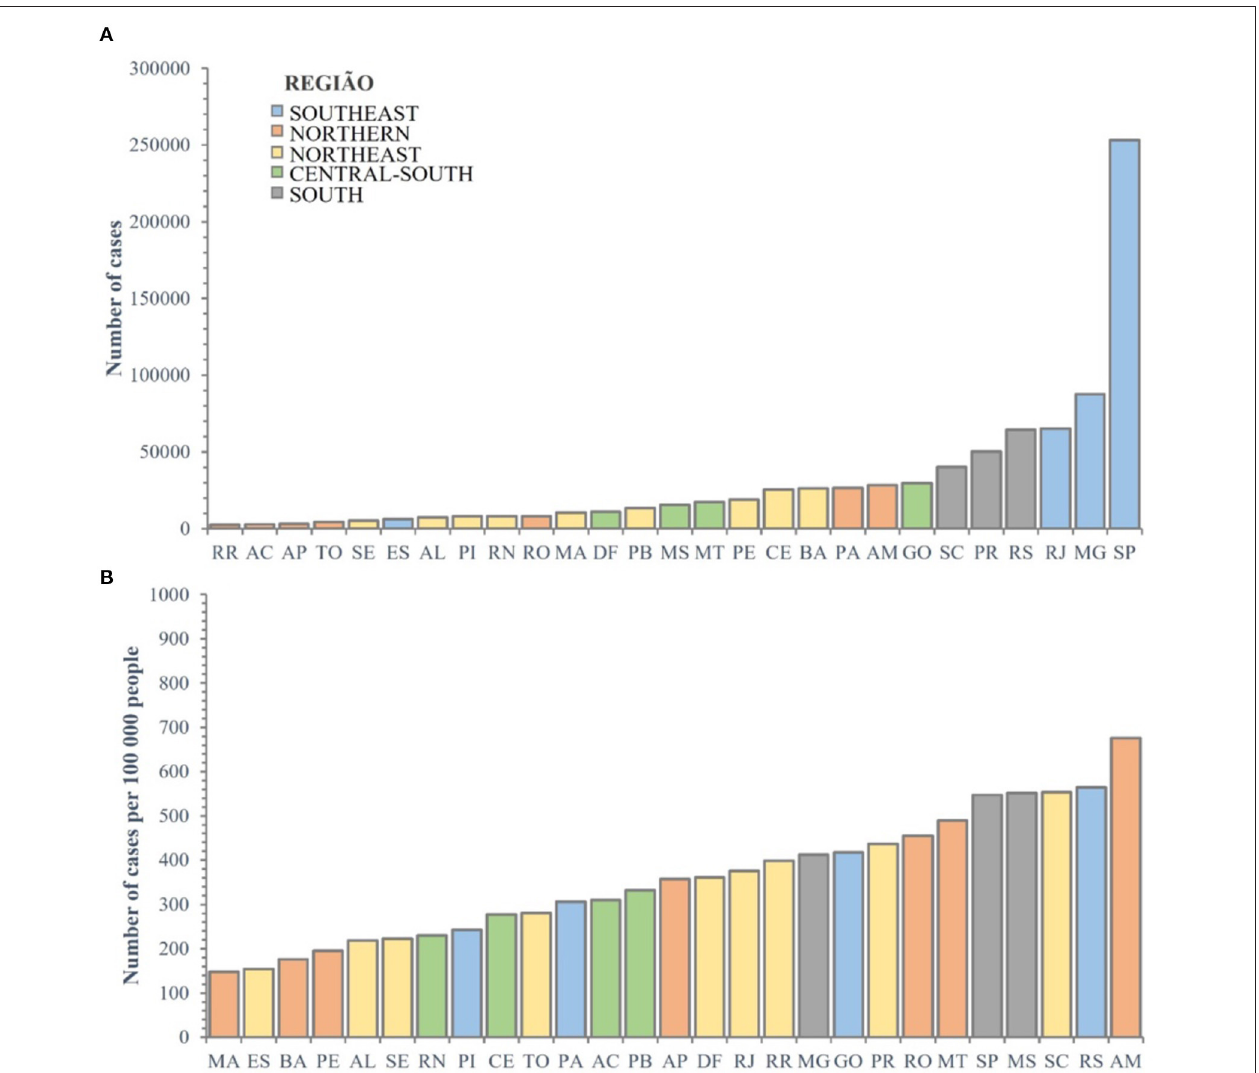
FIGURE 2 | (A,B) Distribution of absolute number of cases among Brazilian states and the Federal District, and number of cases per 100,000 inhabitants. Cases = 840201. AC, Acre; AL, Alagoas; AM, Amazonas; AP, Amapá; BA, Bahia; CE, Ceará; DF, Distrito Federal; ES, Espírito Santo; GO, Goiás; MA, Maranhão; MG, Minas Gerais; MS, Mato Grosso do Sul; MT, Mato Grosso; PA, Pará; PB, Paraíba; PE, Pernambuco; PI, Piauí; PR, Paraná; RJ, Rio de Janeiro; RN, Rio Grande do Norte; RO, Rondônia; RR, Roraima; RS, Rio Grande do Sul; SC, Santa Catarina; SE, Sergipe; SP, São Paulo; TO,